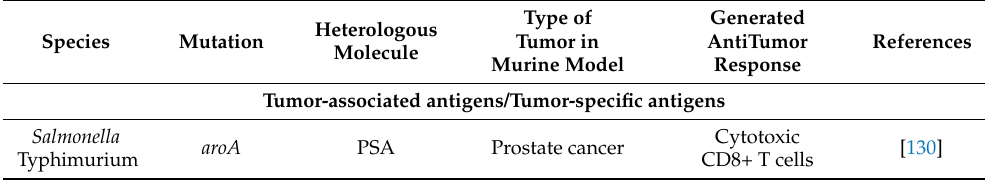
Table 2. Salmonella enterica as a carrier of antitumor heterologous